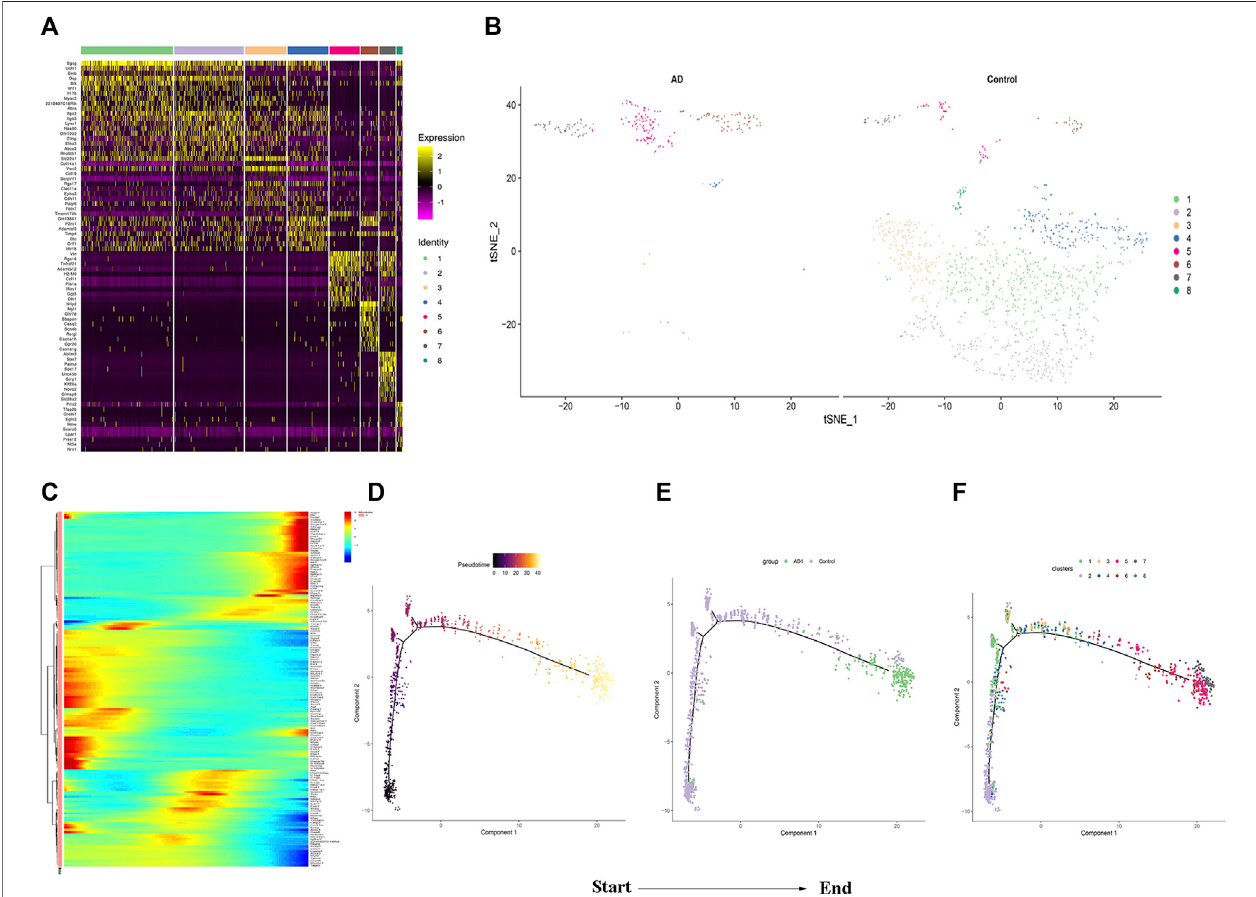
FIGURE 5 | Analysis of smooth muscle cell subgroup . (A) Heatmap of the top 10 enriched genes in each SMCs population. (B) Distribution of SMCs Subgroup betweenthetwogroups. (C) Theheatmapoftop50geneswhichhadmostcriticalin fl uencesoncelltransformation. (D) TimeprogressionofSMCsdifferentiation. (E) and (F) SMCs differentiation trajectory.